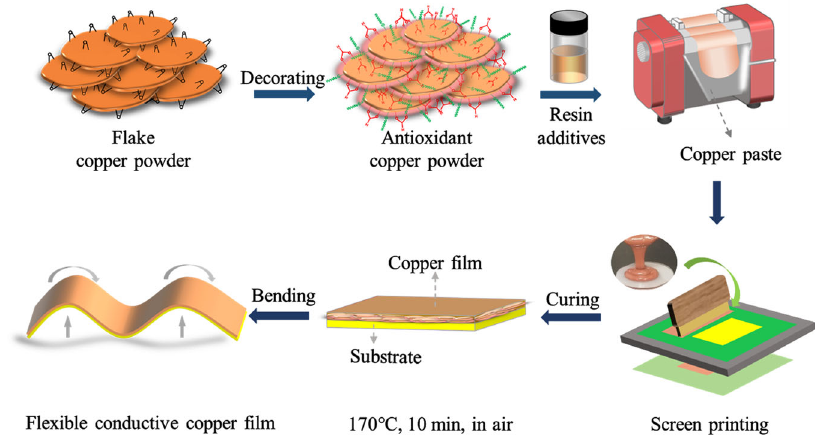
Fig. 1 General scheme for fabricating antioxidant copper paste and screen printing fl exible electronics. The entire process to prepare the fl exible electronics includes: decorating the fl ake copper powder, mixing & grinding the copper powder and solvent (containing resin additives and others), screen printing on fl exible substrates, and curing the wet fi lms in air at 170 °C for 10 min to form fi nal fl exible conductive fi